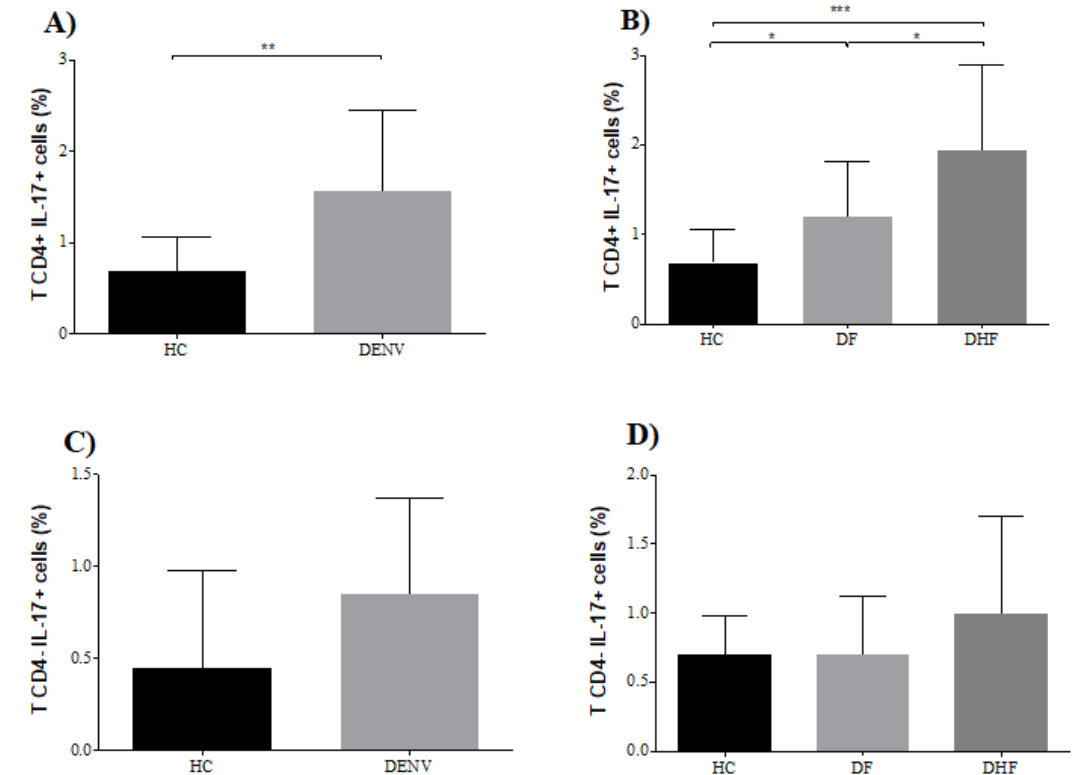
Figure 6. Higher percentage of CD3 + CD4 + IL-17-producing cells in DENV-infected patients. ( A ) Percentage of IL-17 + cells in HC ( n = 12) and DENV-infected patients ( n = 24). ( B ) Percentage of IL-17 + cells in HC ( n = 12), DF patients ( n = 12) and DHF patients ( n = 12). ( C ) Percentage of CD3 + CD4-IL-17 + cells in HC ( n = 12) and DENV-infected patients ( n = 24). ( D ) Percentage of CD3 + CD4-IL-17 + cells in HC ( n = 12), DF patients ( n = 12) and DHF patients ( n = 12). Statistical di ff erence is based on Student’s t -test ( A ), Mann–Whitney test ( B ), one way analysis of variance (ANOVA) with Holm–Sidak’s multiple comparison test ( C ) and the Kruskal–Wallis with Dunn’s multiple comparison post-tests ( D ). * p < 0.05, ** p < 0.01, *** p <